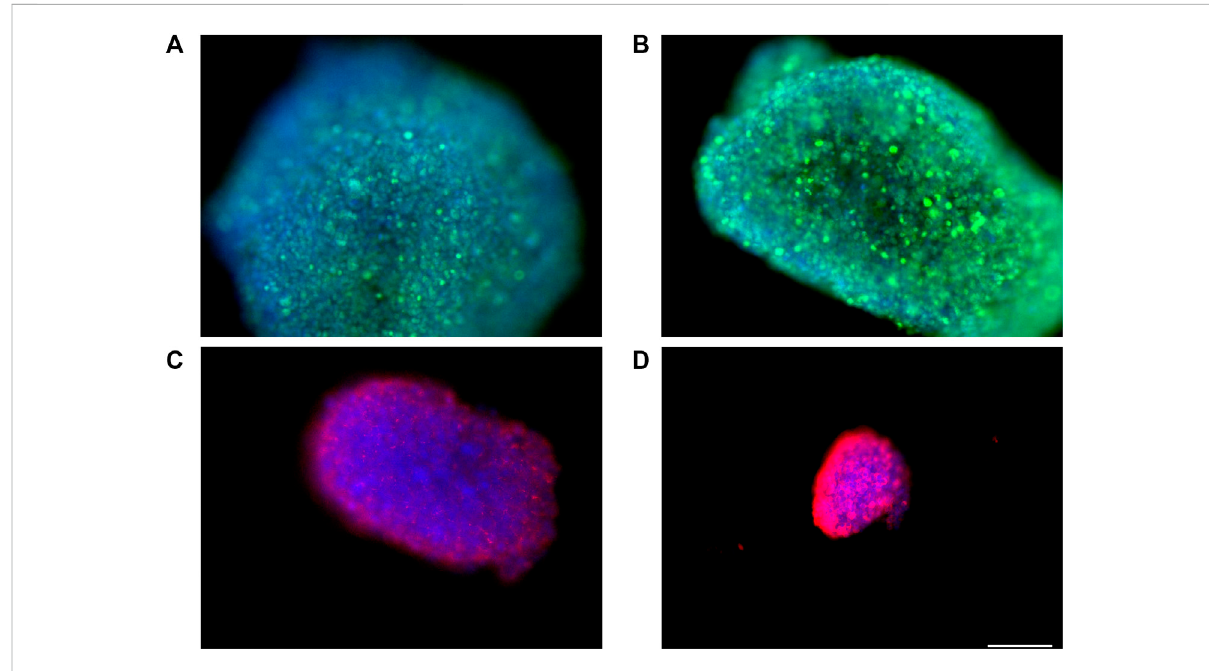
FIGURE 10 Representative image of spheroids obtained by culturing human neuroblastoma SH-SY5Y SH-SY5Y cells in the lower chamber of LB2/ bEnd.3 cells. Spheroids were immunoreacted with Ki-67 antibody, ( GFP, A , B) , ZO1 ( RFP, C), and β -tubulin III ( RFP, D) . Nuclei, DAPI. Images were acquired as Z stacks with the JuLI Stage fl uorescence recorder, and the maximum intensity projection was shown. The scale bar was 250